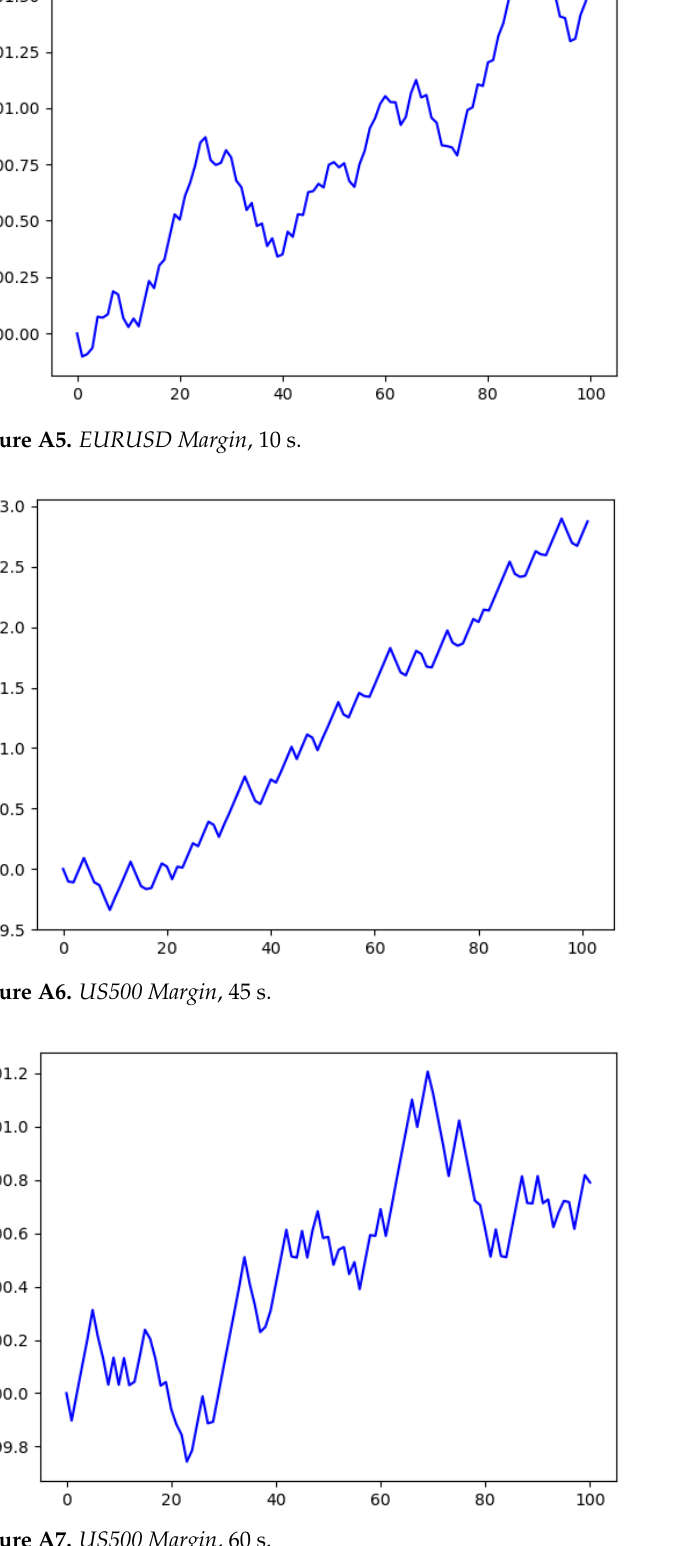
Figure A7. US500 Margin , 60